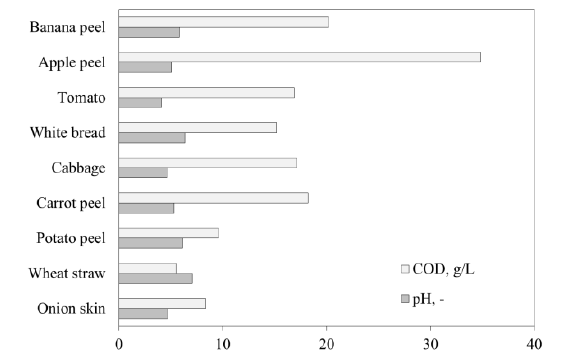
Figure 1. Physico-chemical characterization of